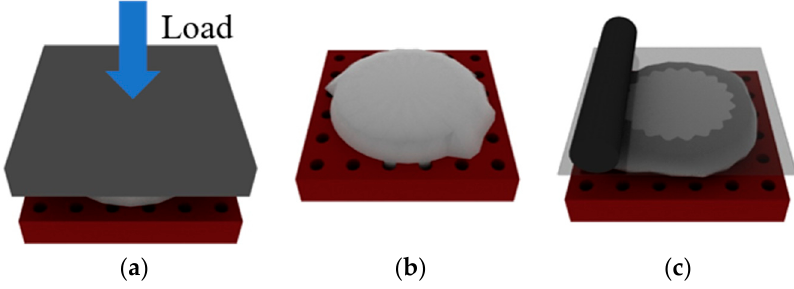
Figure 4. Fabrication processes used to produce polymer samples from fluorosilicone molds. ( a) Hot embossing; ( b ) vacuum; and ( c ) lamination .